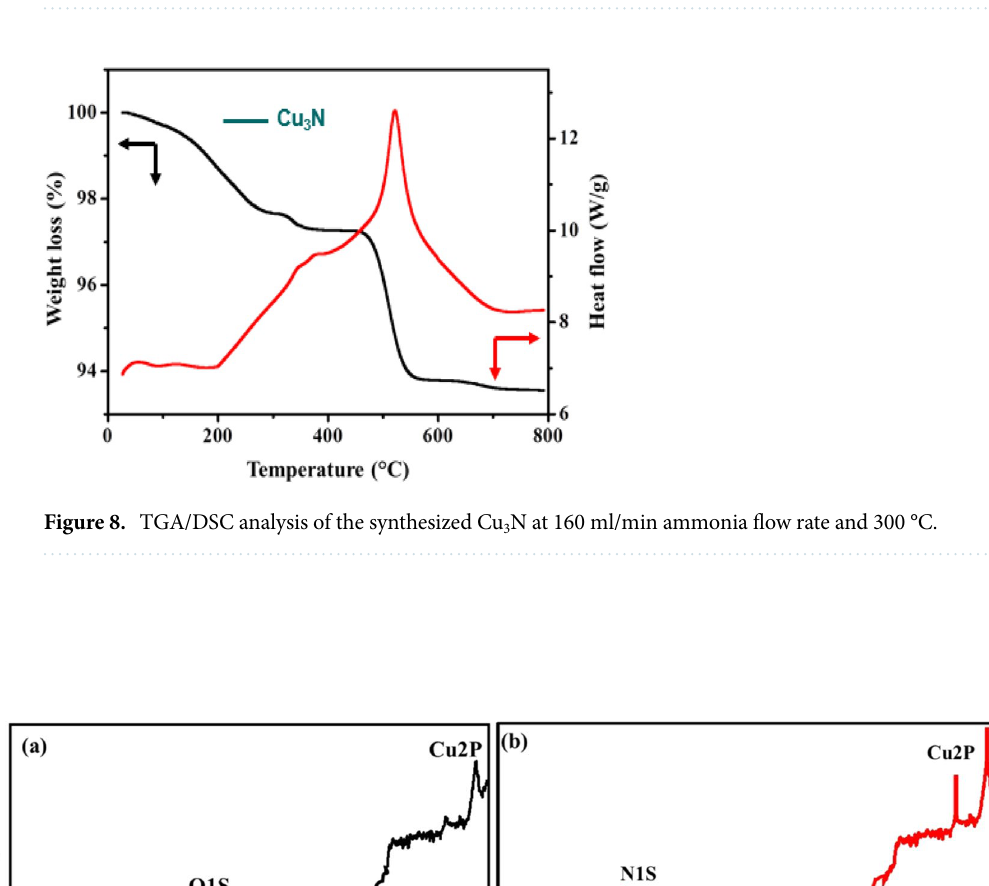
Figure 7. BET surface area analysis calculated from N 2 adsorption–desorption isotherms of Cu 3 N nanoparticles (synthesized at 160 ml/min ammonia flow rate and 300 °C).